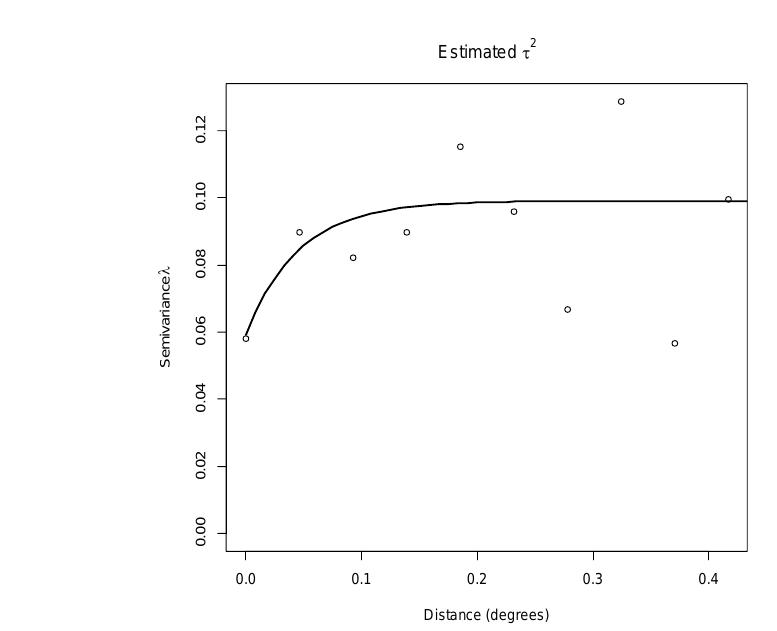
Figure 5. Semivariogram showing autocorrelation at 15.21 km.